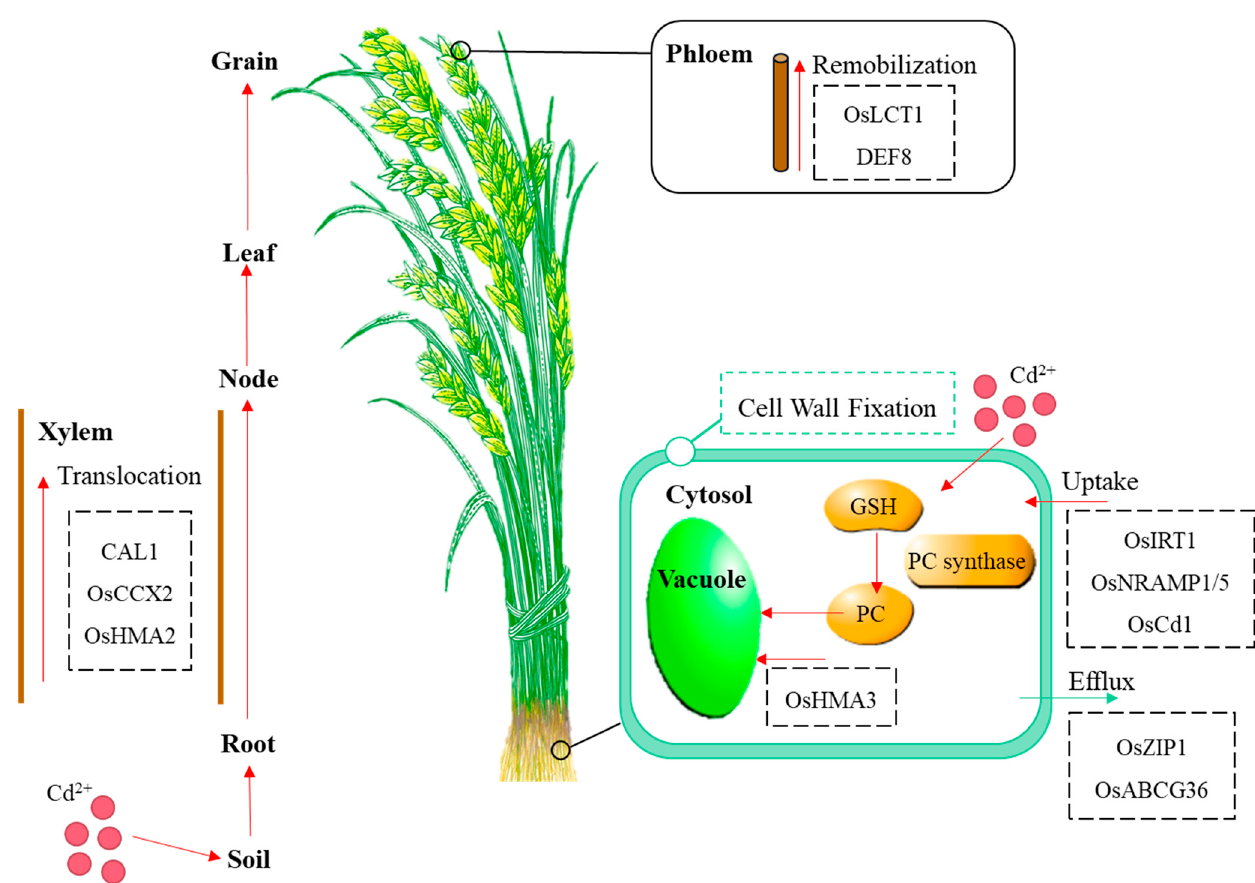
Figure 1. Transporters involved in the absorption and transport of Cd from soils to grains in rice. The pathways of Cd absorption by roots include Cd absorption and efflux by transporters, Cd fixation by the cell wall, and Cd chelation by vacuoles. Cd is transported to shoots by loading into the xylem. Then, Cd will be redistributed through stems and nodes and further translocated to grains through the phloem.